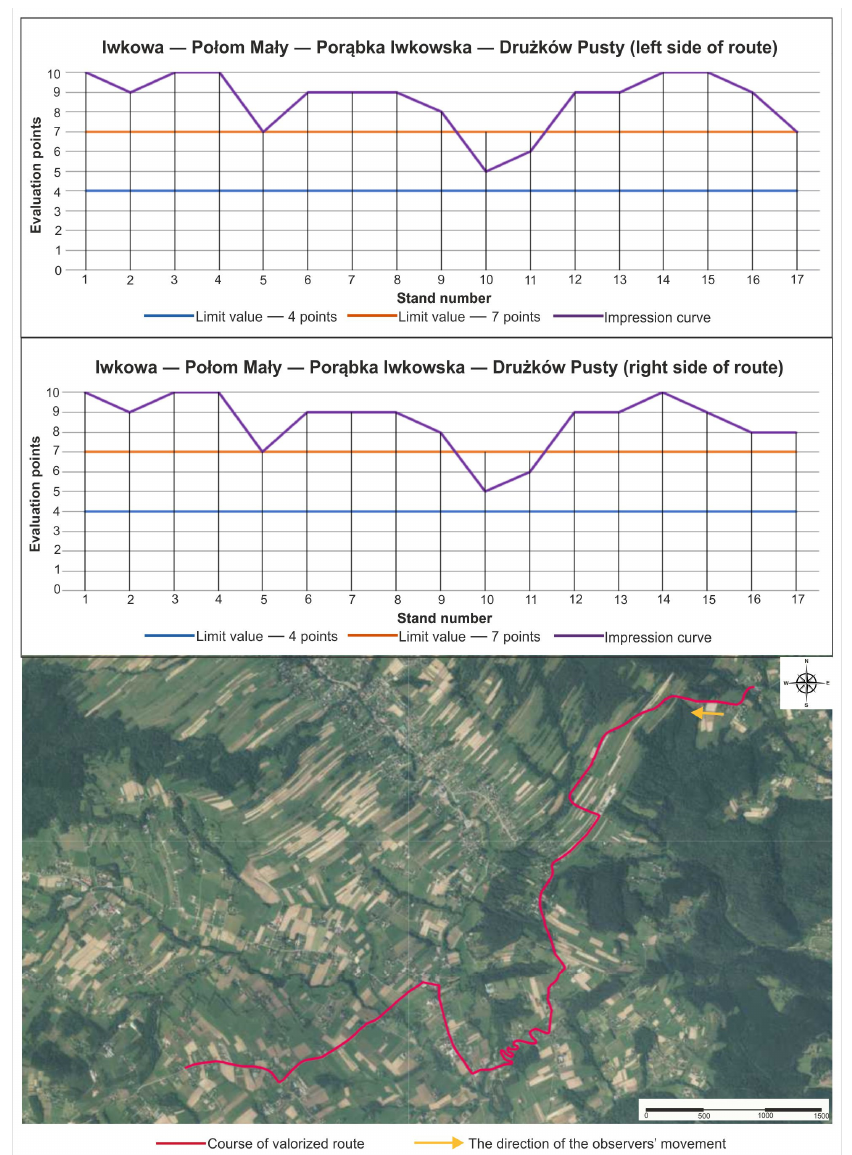
Figure 14. Impression curves for the Iwkowa—Po ł om Ma ł y—Por ą bka Iwkowska—Dru ż ków Pusty route (Commune of Iwkowa).